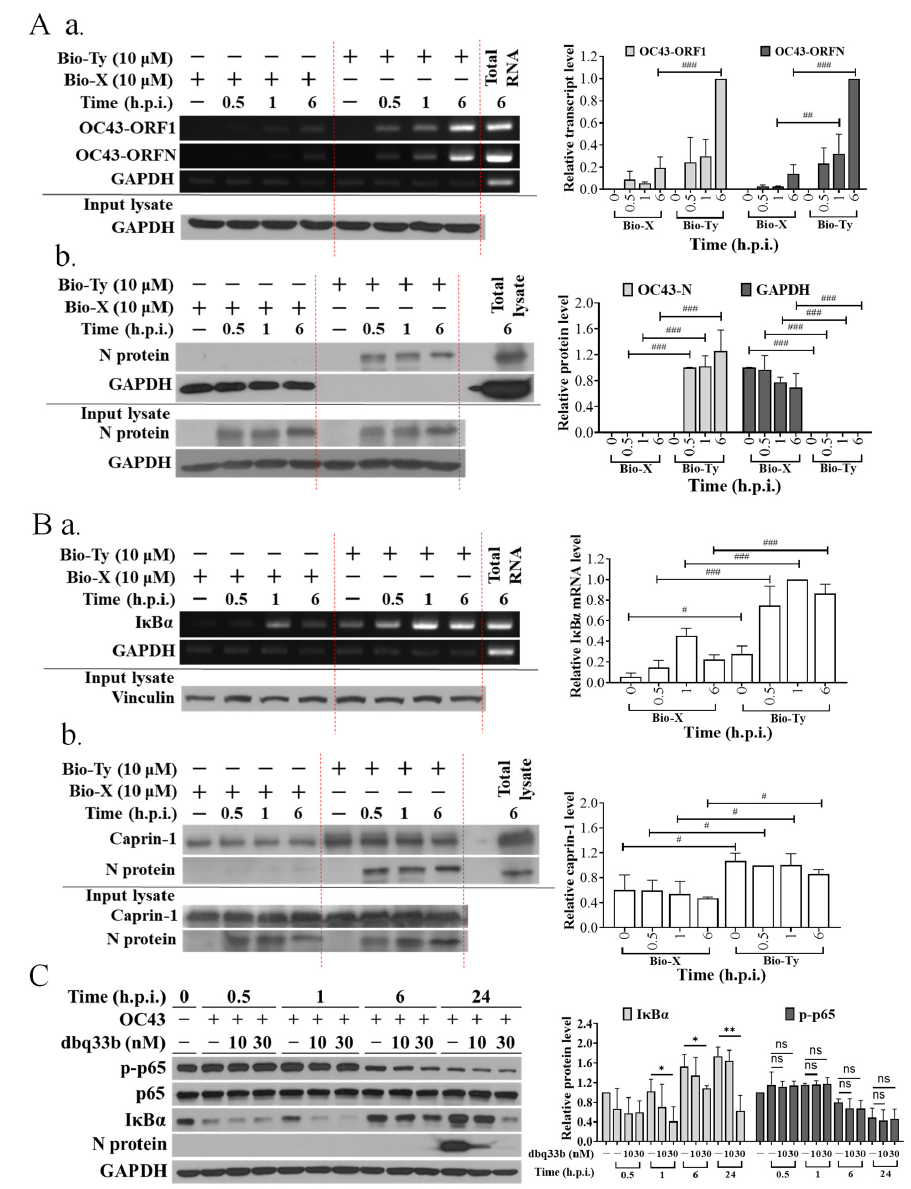
Figure 1. Viral and cellular targets of tylophorine-based compounds in HCoV-OC43-infected cells. ( A ) Tylophorine compounds interacted with HCoV-OC43 viral genomic RNA and nucleocapsid (N) protein. Biotinylated tylophorine interacted with HCoV-OC43 viral RNA ( a ) and N protein ( b ). ( B ) Tylophorine compounds interacted with host cellular I κ B α mRNA and caprin-1 protein. Biotiny- lated tylophorine interacted with I κ B α mRNA ( a ) and caprin-1 protein ( b ). ( C ) dbq33b diminished I κ B α and viral antigen N protein levels in HCoV-OC43-infected HCT-8 cells. Lysates of